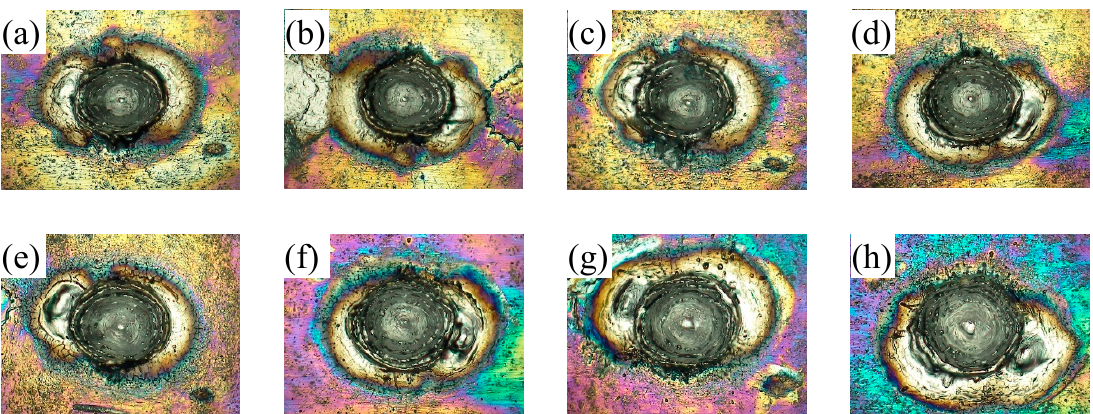
Figure 3. Top-view optical microscope images of ablation craters. (a) 50 °C; (b) 100 °C; (c) 150 °C; (d) 200 °C; (e) 250 °C; (f) 300 °C; (g) 350 °C; (h) 400 °C.